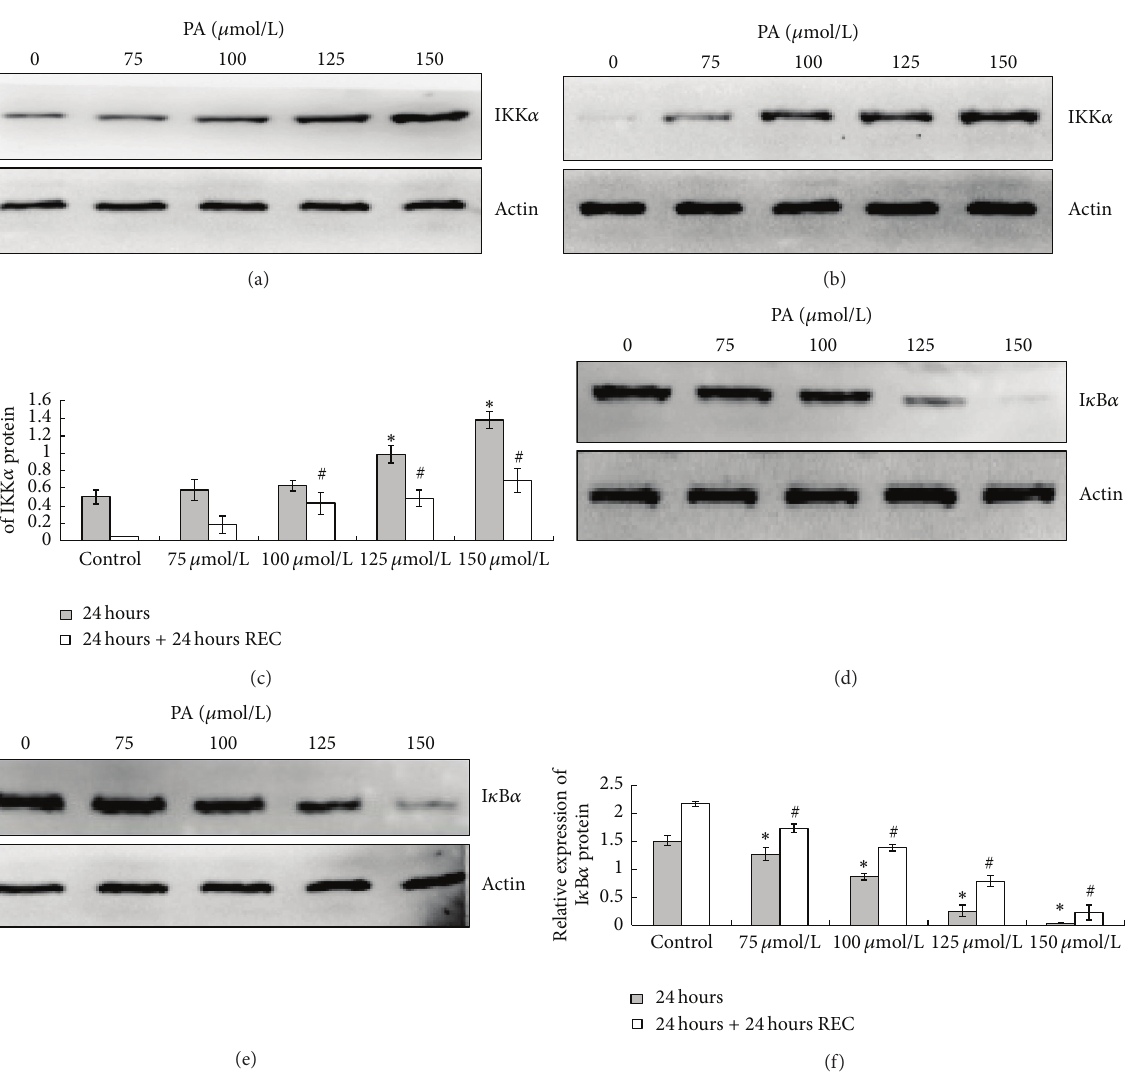
Figure 4: PA induces activation of IKK 𝛼 and degradation of I 𝜅 B 𝛼 in HaCaT cells measured by western blotting. Keratinocytes were untreated or treated with PA (75, 100, 125, and 150 𝜇 mol/L) for 24 hours under serum-free conditions. The cells were harvested, and nuclear extracts were analyzed with IKK 𝛼 by western blot immediately after the treatment (a) and 24 hours after the PA depletion (b). The densitometry values are means ± SD of three independent experiments (c). The protein expression of I 𝜅 B 𝛼 immediately after the treatment (d) and 24 hours after the PA depletion (e) were also determined by western blot. The densitometry values are means ± SD of three independent experiments (f). ∗ indicate significant differences of 𝑃 < 0.05 , respectively, between the PA-treated groups and nontreated group immediately after the treatment groups (24 hours); # indicate significant differences of 𝑃 < 0.05 , respectively, between the PA-treated groups and nontreated group in 24 hours after the PA depletion groups (24 hours + 24 hours